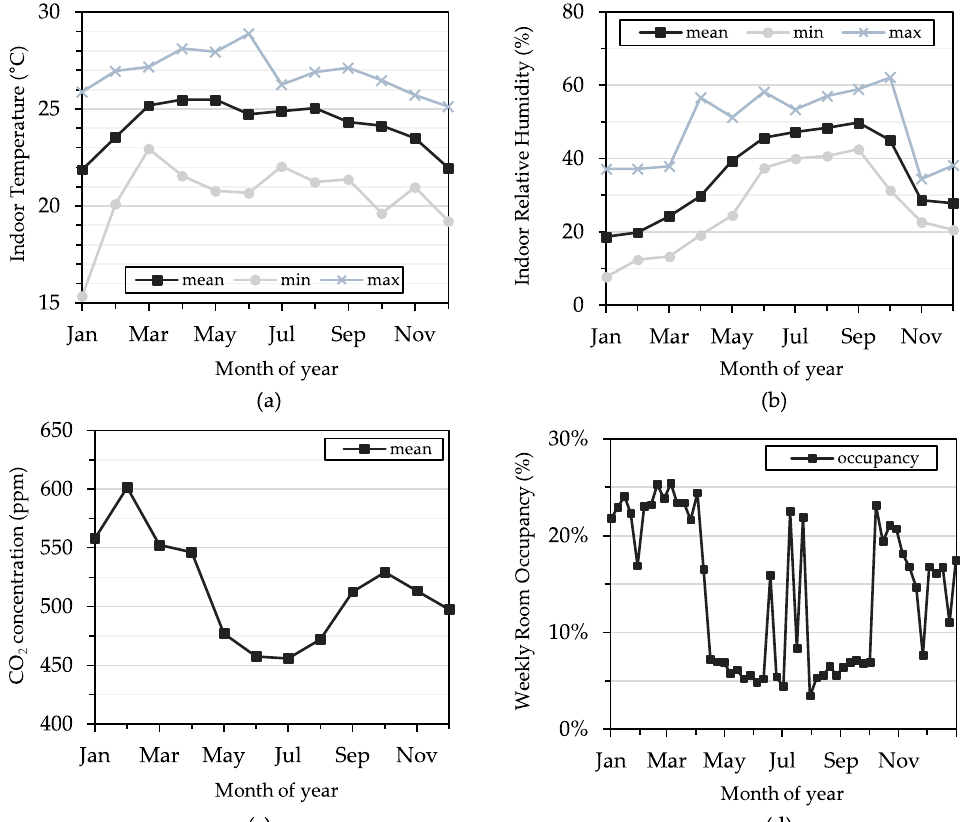
Figure 8. Annual trends showing monthly ( a ) temperature, ( b ) relative humidity, ( c ) CO 2 concentration, and ( d ) weekly occupancy percentage in a research lab and student office space in an academic building.